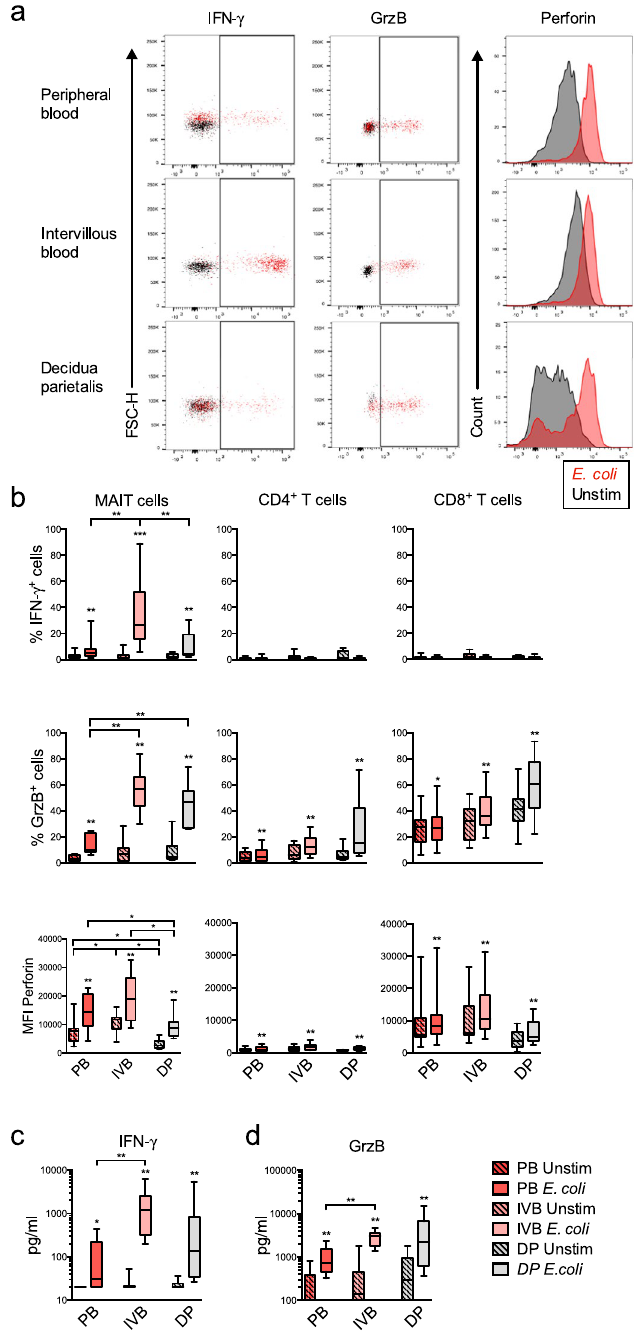
Figure 3. MAIT cells at the foetal-maternal interface react strongly upon bacterial stimulation. ( a ) Representative flow cytometry dot plots and histograms showing the unstimulated sample in black and the E . coli stimulated sample in red. ( b–d ) Comparison between paired samples of peripheral blood (PB) (red), intervillous blood (IVB) (light red), and decidua parietalis (DP) (grey) cells. The unstimulated condition is shown with diagonal stripes, and the sample stimulated with E . coli without. ( b ) (Top row) Intracellular expression of IFN- γ in MAIT cells, CD4 + , and CD8 + T cells ( n = 12). (Middle row) Intracellular expression of Granzyme B (GrzB) in MAIT cells, CD4 + and CD8 + T cells ( n = 10). (Bottom row) Intracellular mean fluorescent intensity (MFI) of perforin in MAIT cells ( n = 9), CD4 + ( n = 10) and CD8 + T cells ( n = 10). Levels of ( c ) IFN- γ , ( n = 10) and ( d ) GrzB ( n = 10) measured with ELISA in paired samples of culture supernatants following 16 hours of culture with or without E . coli stimulation. Box and whisker plots show median, interquartile range and range of paired samples. In b , c and d , the Wilcoxon signed rank test was used to detect statistically significant differences between paired unstimulated and stimulated samples, stars indicate significances. The Friedman test followed by the Wilcoxon signed rank test was used to detect statistically significant differences across multiple paired samples ( b – d ). A Bonferroni corrected p value was used for multiple comparisons. * P < 0.05, ** P < 0.01, *** P <